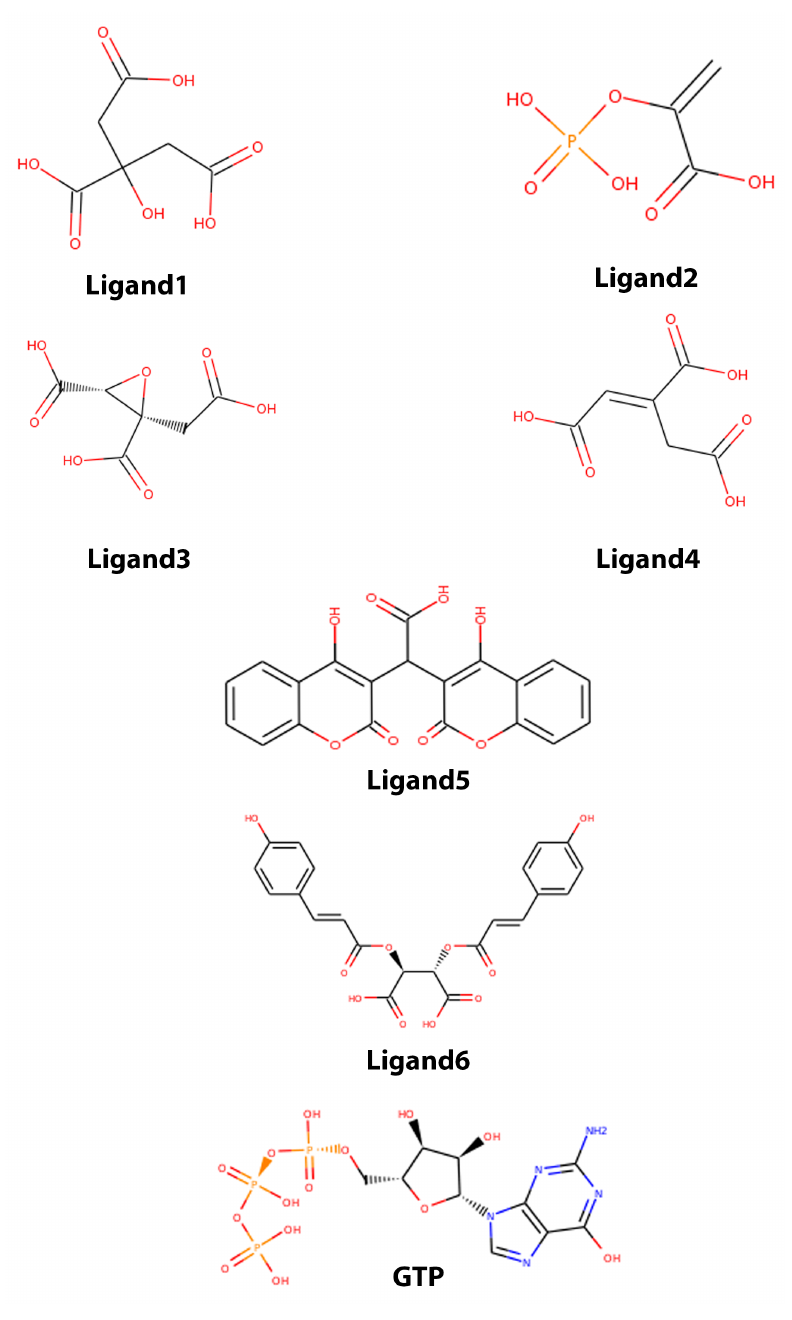
Figure 4. 2D structure of the six ligands with best MM/PBSA